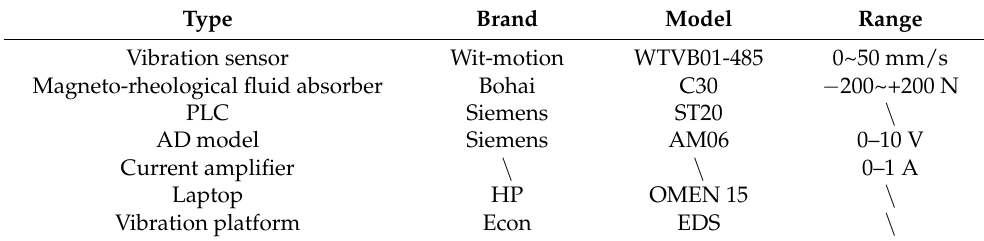
Table 2. Experimental equipments brands and models.